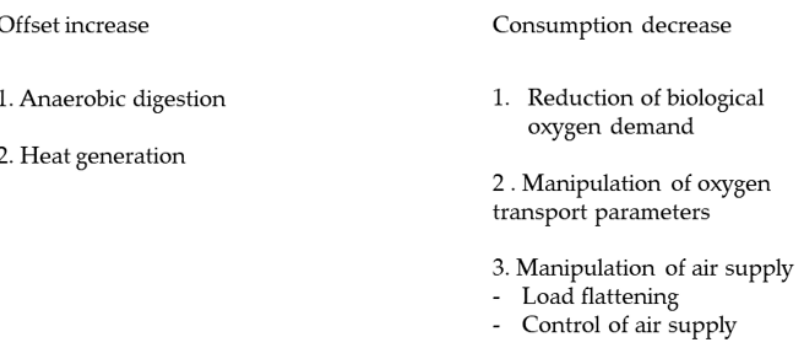
Figure 1. Energy efficiency improvement possibilities in STPs.